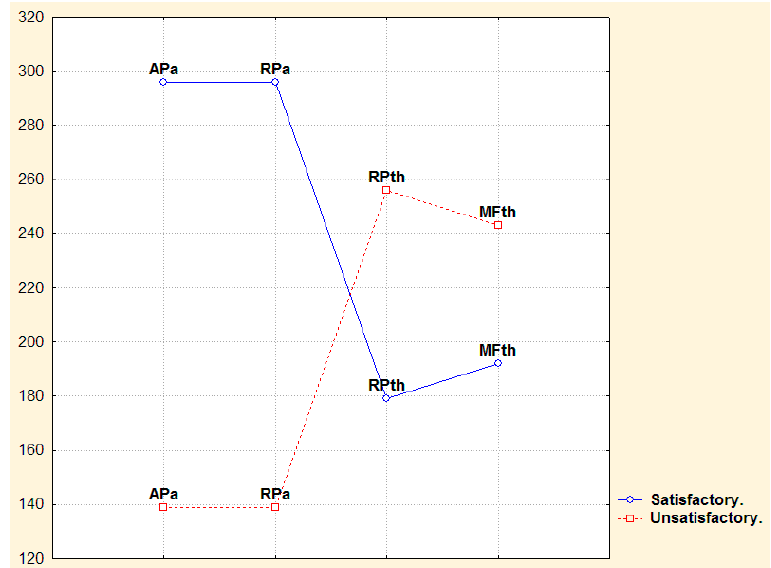
Figure 3. Mann Whitney. Representation of mirror behavior of theta and alpha broad-band measures in satisfactory and unsatisfactory post-surgical evolution patients in the second year after surgery. ThrP (theta relative power), ThMF (theta mean frequency), AaP (alpha absolute power), ArP (alpha relative power).